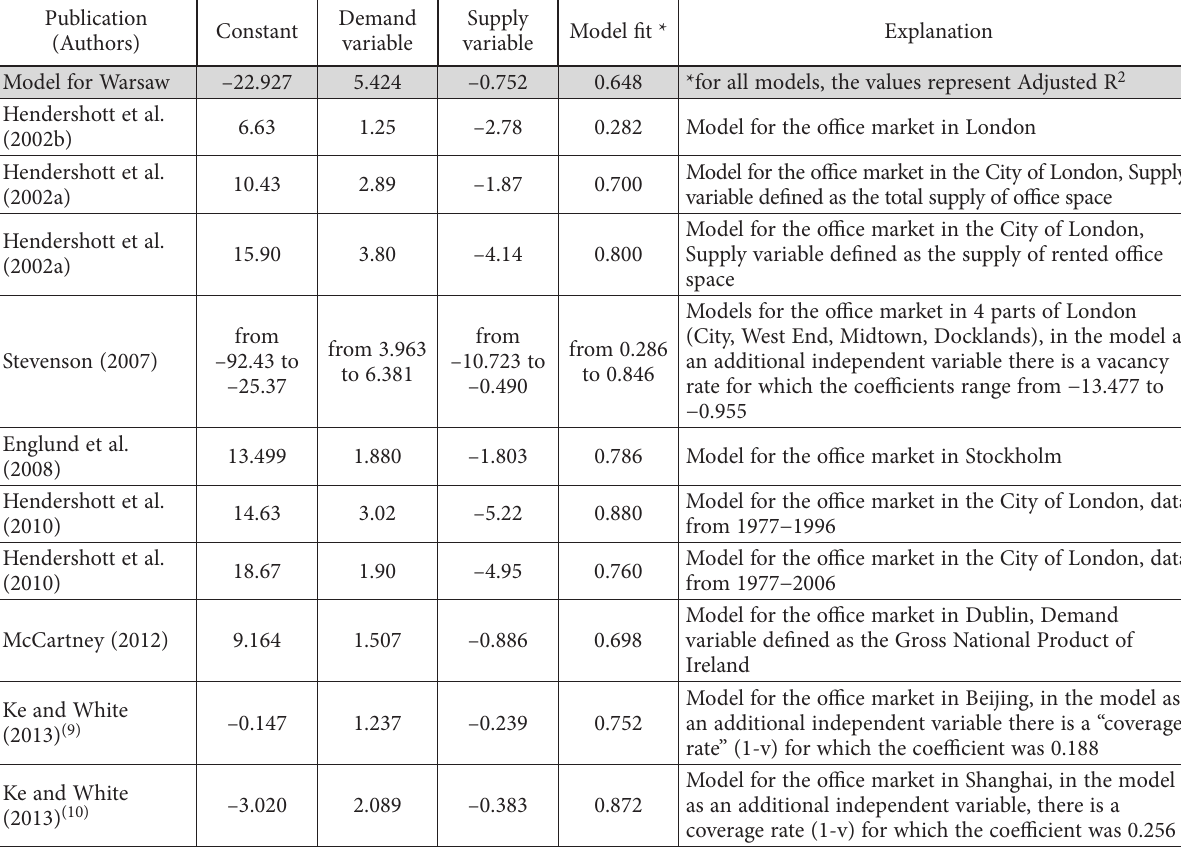
Table 8. Comparison of coefficients of long-term equation of the symmetric model with previous studies (source: own study) Publication